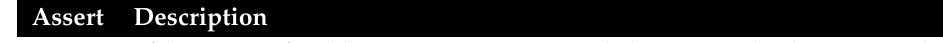
Table 2. Assertions in the post-test